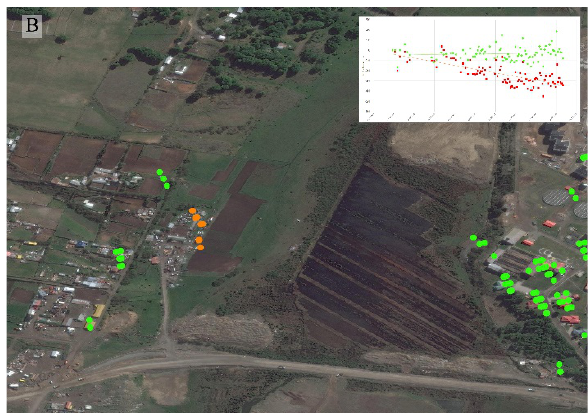
Figure 4. Example of displacement area and time series.